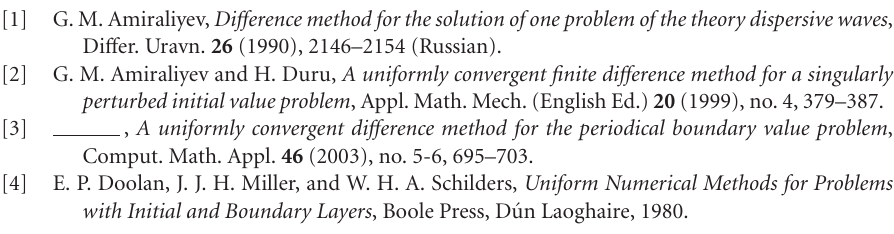
} on ω = 1 / 16 and h = 1 / , p ε , h h for h u λ